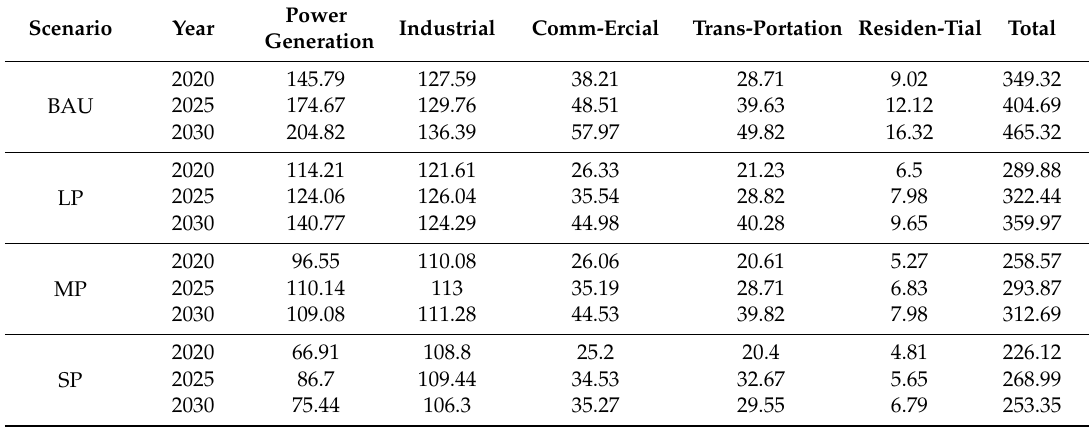
Table 5. CO 2 emissions under the di ff erent scenarios for di ff erent sectors (unit: Mt).